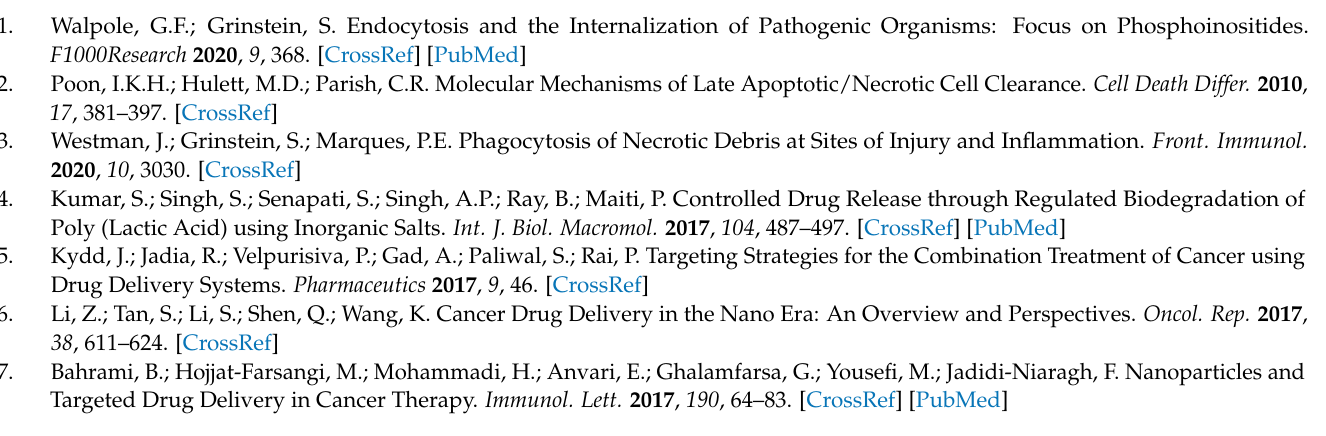
Figure S2: Cell confluency’s effect on uptake in plate, Figure S3: 3DCFS incubated cell’s recovery, Figure S4: Uptake fitting for particle uptake in the 3DCFS device, Video S1: Time evolution of A375 cells’ 2.4 µ m fluorescently tagged polystyrene particle